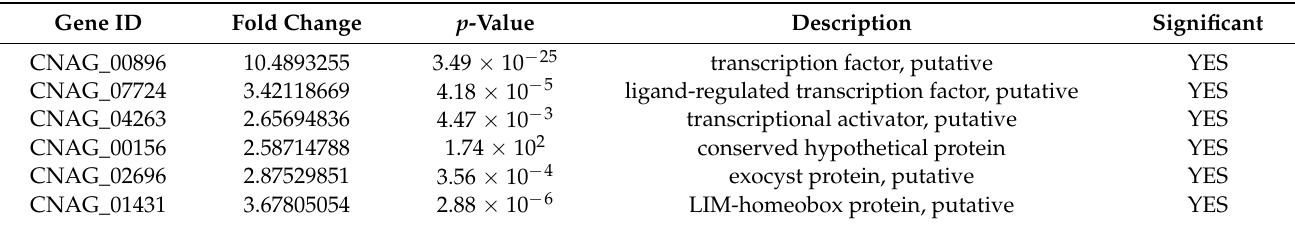
Table 3. Expression of genes encoding the known transcription factors associated with FLC resistance under low glucose when compared to normal glucose. Gene